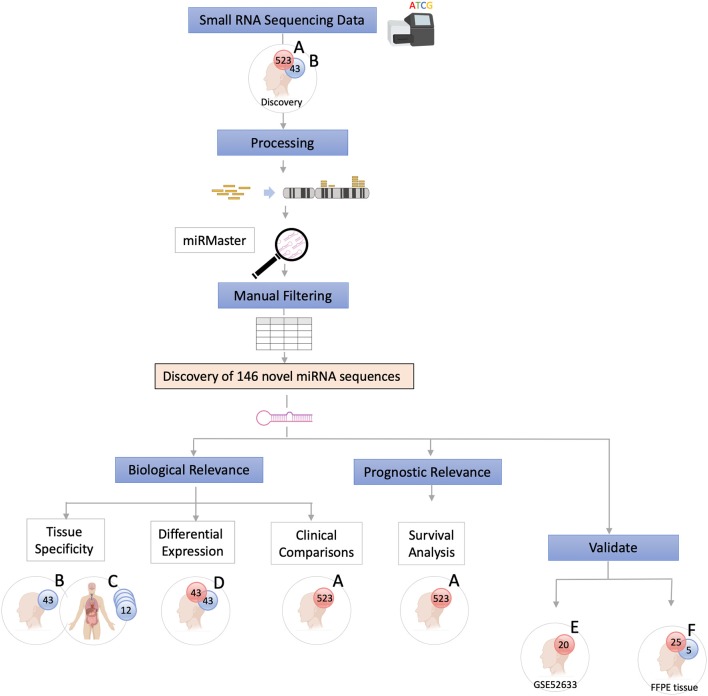
Study Flow Chart. High throughput small RNA-sequencing data from head and neck squamous cell carcinoma (HNSCC) (n = 523, dataset A) and matched non-malignant tissue (n = 43, dataset B) were obtained from The Cancer Genome Atlas (TCGA). Raw sequence data (BAM files) were converted into unaligned reads (FASTQ) and inputted into miRMaster for miRNA detection and quantification. A threshold criteria of ≥1 read per million (RPM) in ≥10% of samples per group was employed. To determine whether these novel sequences have potential biological relevance group comparison and association analyses were performed. Tissue specificity of the novel candidate sequences was assessed by comparing non-malignant samples (dataset B) with those from 12 other non-malignant tissue types from TCGA Pan-Cancer Atlas (dataset C) using non-linear t-Distributed Stochastic Neighbor Embedding. Differentially expressed novel miRNAs were detected by comparing tumor and matched non-malignant samples (dataset D). Clinicopathological features of the novel miRNA transcripts (n = 130) that were found to be expressed exclusively in tumor samples (dataset A) were compared. Survival analysis was performed to further characterize the novel sequences. Cox regression analysis showed that candidate novel miRNA sequences behave similarly to known miRNAs and may have prognostic value. Validation was performed on an independent dataset (Gene Expression Omnibus GSE52633) (dataset E) and by performing RT-qPCR of the most relevant miRNA candidates in formalin-fixed paraffin-embedded (FFPE) tissues (dataset F).